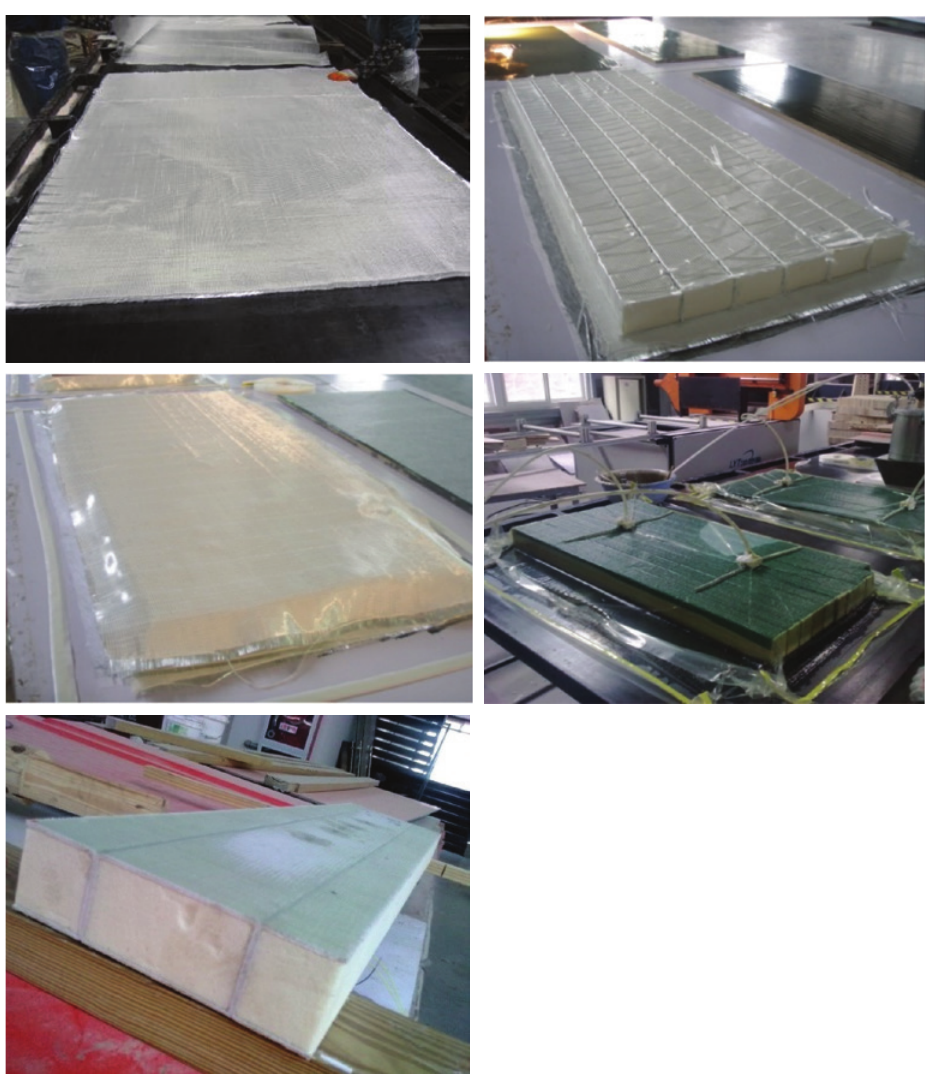
Figure 2: Process of